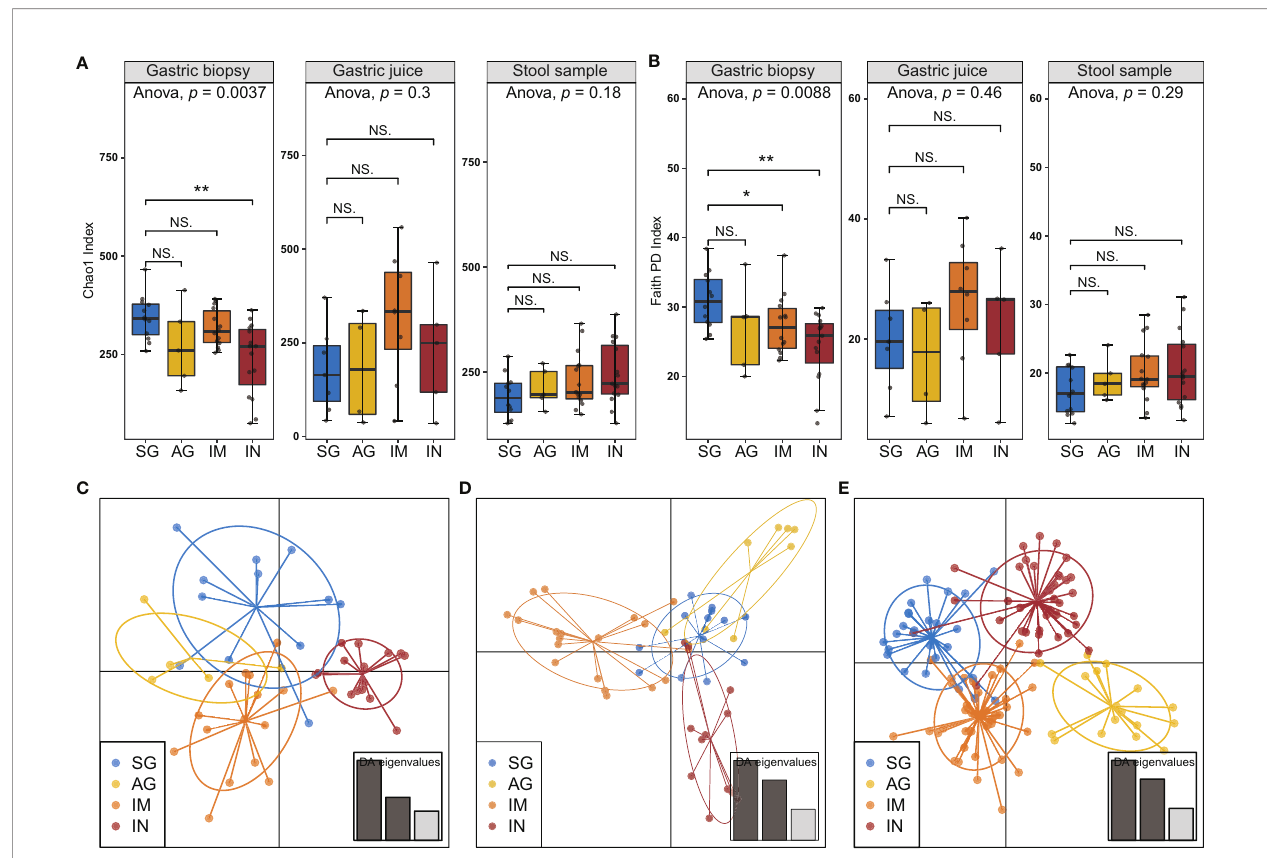
FIGURE 2 | Microbial diversity and community structure in gastric biopsies, juices, and stool samples of H. pylori- negative subjects. Alpha diversity was estimated by (A) Chao1 and (B) Faith ’ s phylogenetic diversity indexes for diagnosis groups. The discriminant analysis of the principal components (DAPC) plot at the features level shows distinct clustering of the diagnosis groups in (C) gastric biopsies, (D) juices, and (E) stool samples. *adjusted p < 0.05. NS, not signi fi cant, ** p <